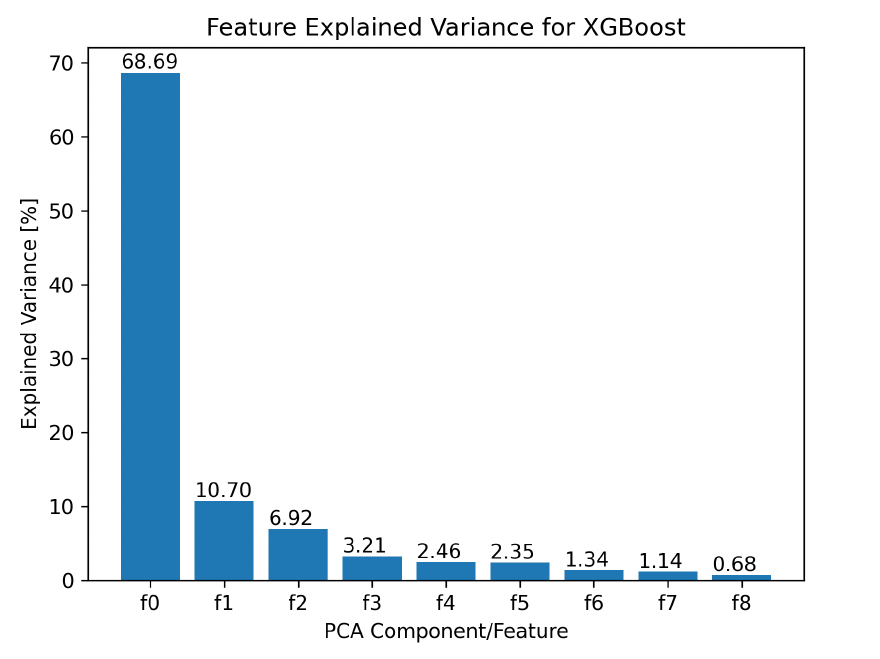
Figure 3. Feature explained variance for XGBoost.